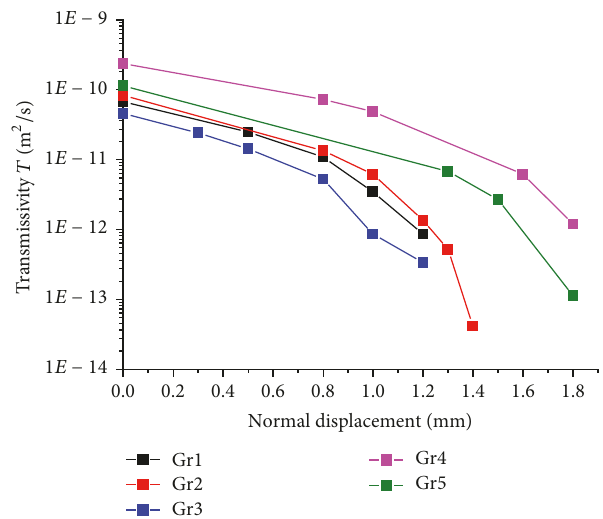
Figure 7: The relationship of transmissivity between normal dis- placements in different